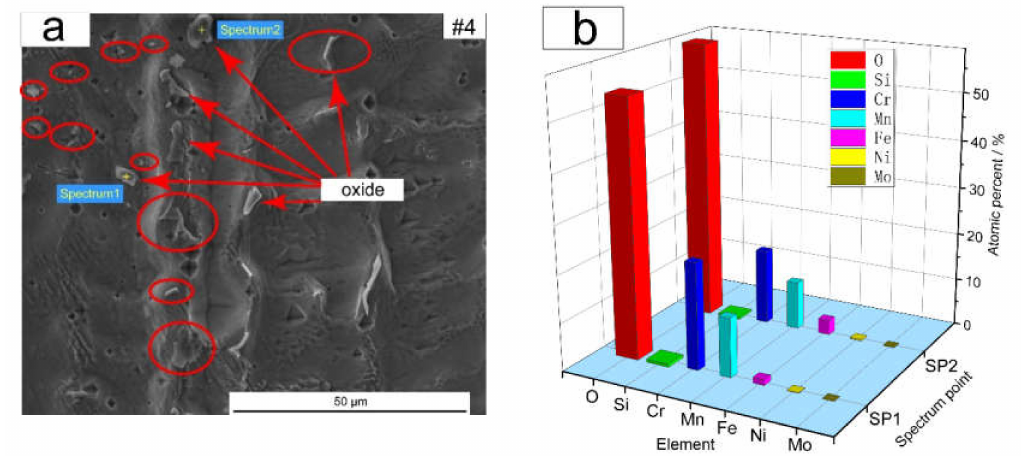
Figure 6. ( a ) microstructure of sample #4 and ( b ) bar chart of element percentage of two particles.